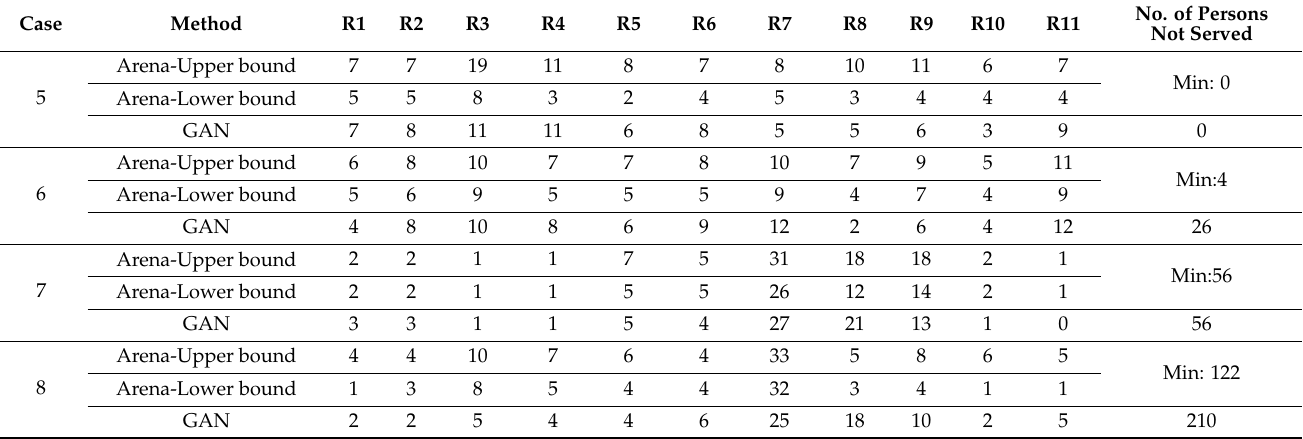
Table 10. Results of Arena and GAN’s Station-Car sets used in last four Req-Reg